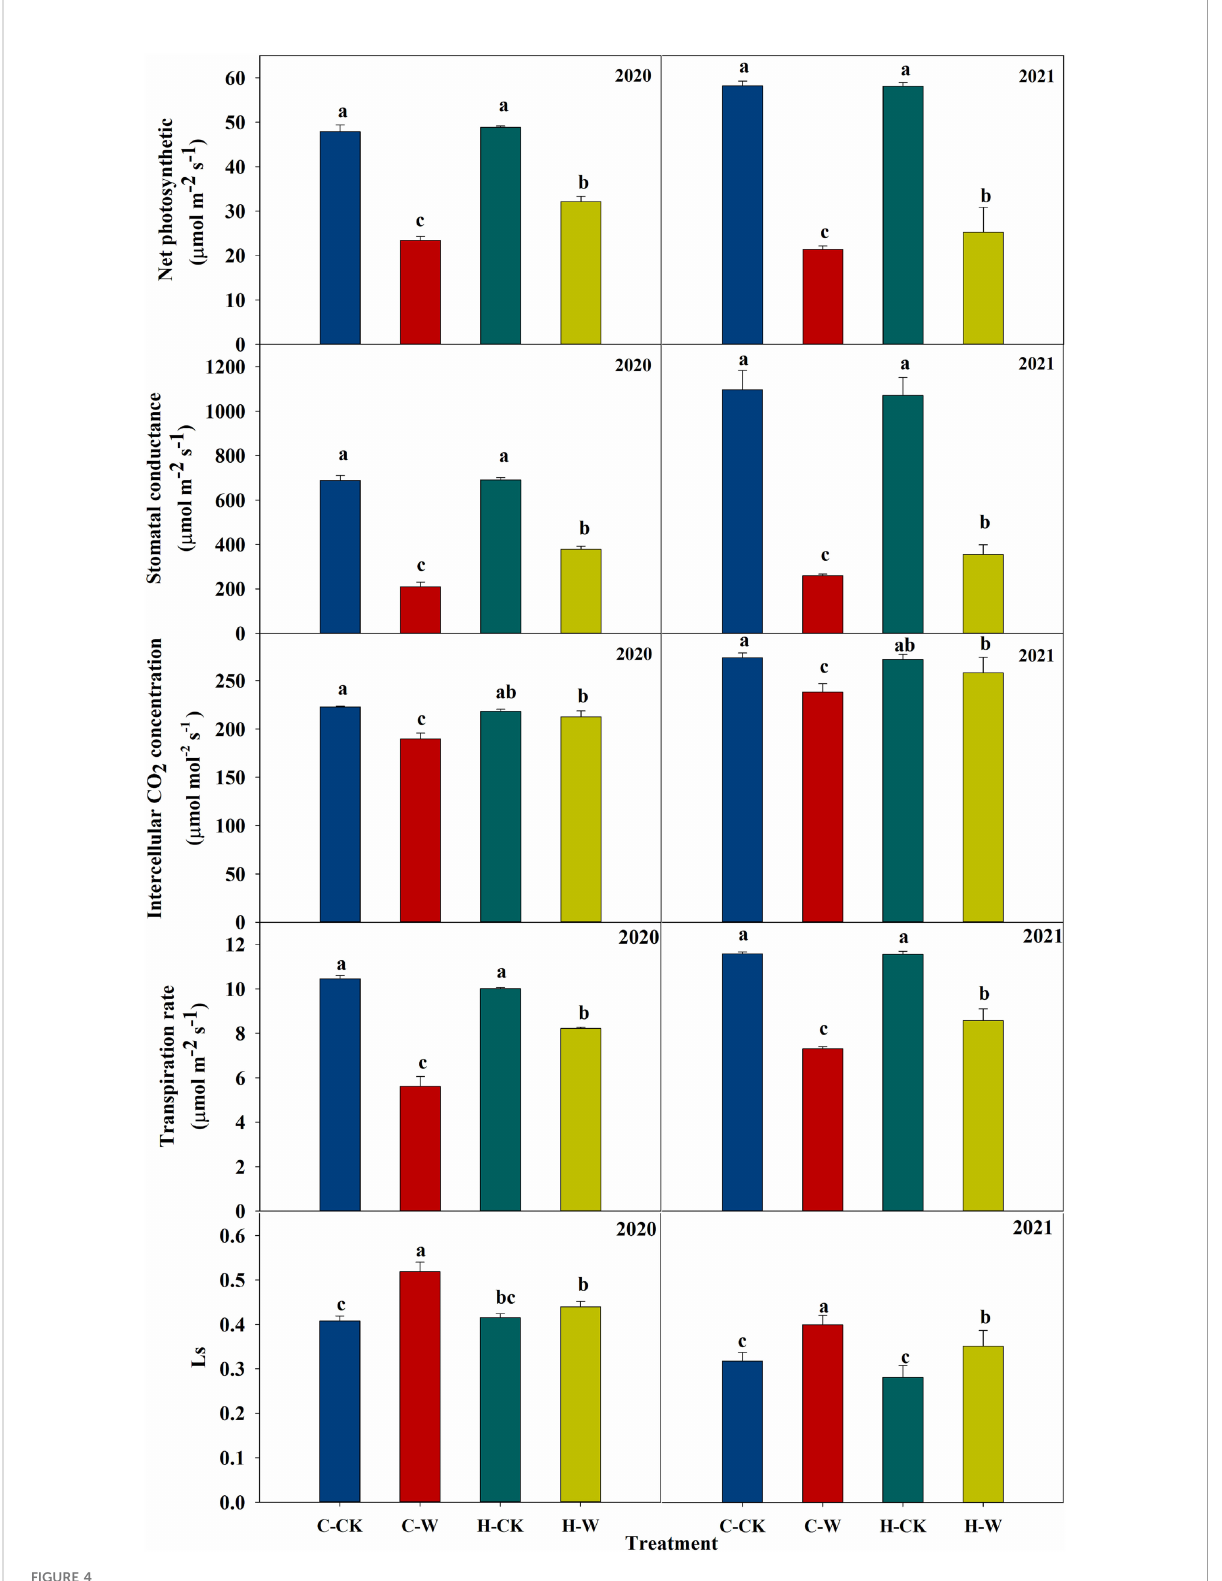
FIGURE 4 Effects of H 2 O 2 priming on gas exchange parameters of summer maize under waterlogging stress at the seedling